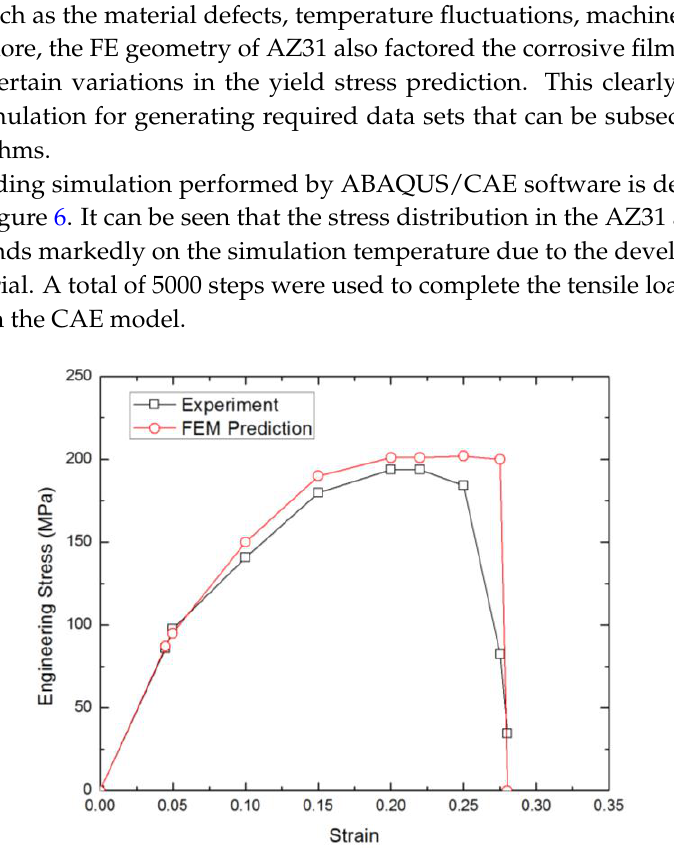
Figure 5. Comparison of tensile force of SS304 alloy predicted from FEM simulation with experimental data obtained from Ref. [24].